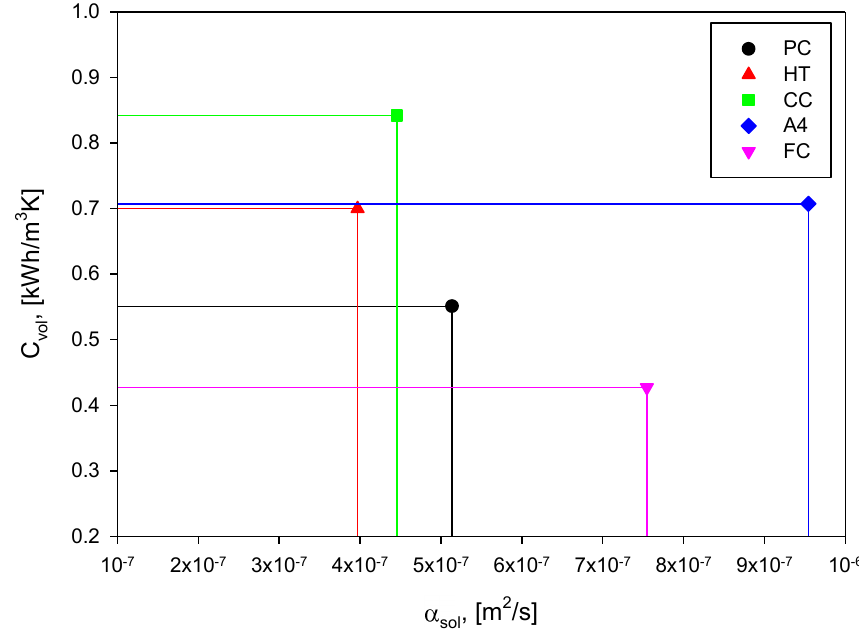
Figure 4. Thermal properties of selected storage